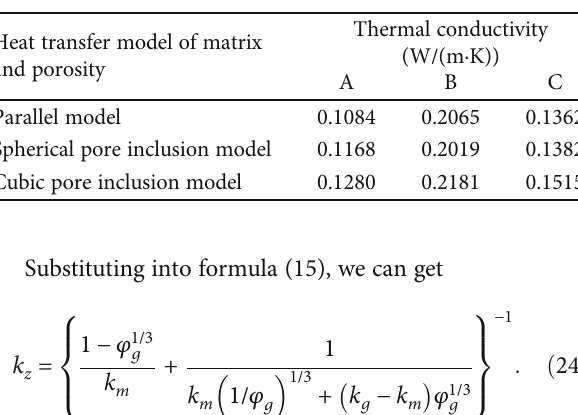
Table 1: Result comparison of di ff erent heat transfer models of matrix and porosity.